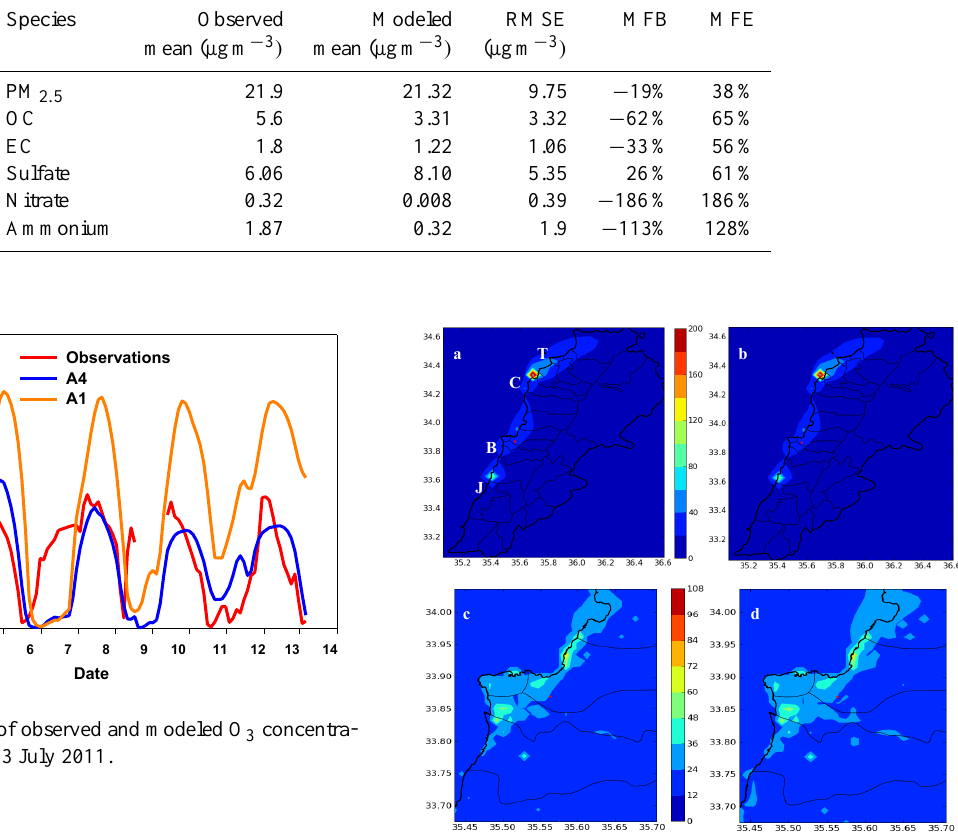
Figure 7. Modeled average PM 2.5 concentrations in µg/m 3 in Lebanon ((a) simulation A1 and 2 Fig. 7. Modeled average PM 2 . 5 concentrations in µgm − 3 in (b) simulation A4) and in the city of Beirut and its suburbs ((c) simulation A1 and (d) 3 Lebanon ( (a) simulation A1 and (b) simulation A4) and in the city simulation A4). (T = Tripoli; C = Chekka ; B = Beirut ; S = Sibline). 4 of Beirut and its suburbs ( (c) simulation A1 and (d) simulation A4). (T = Tripoli; C = Chekka ; B = Beirut ; S =